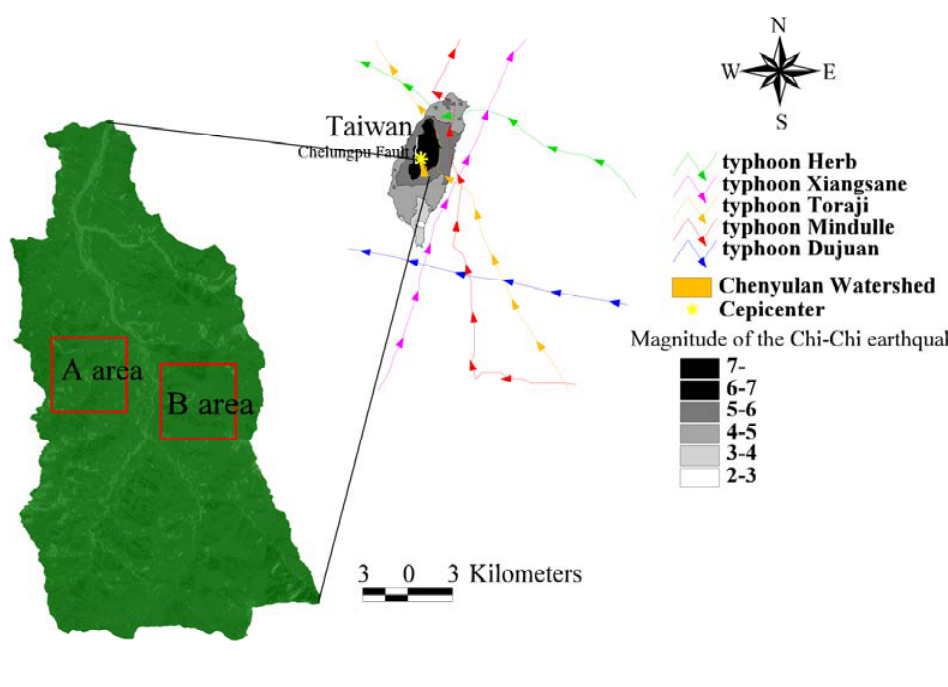
Figure 1. Location of the study